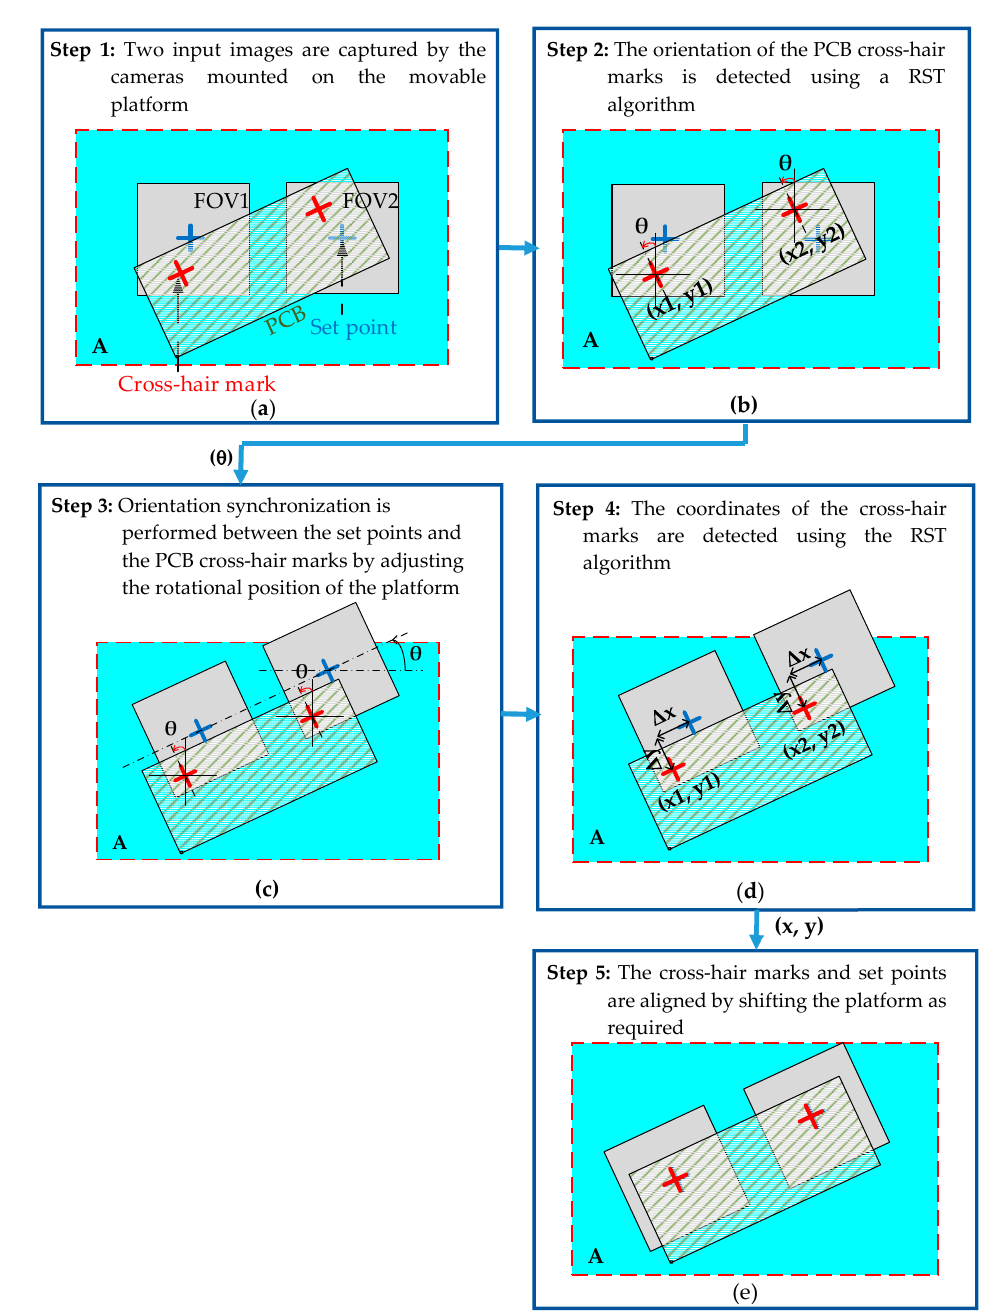
Figure 3. Global framework of the procedure of alignment between the marks on the PCB surface and the set points in the field of views (FOVs) of cameras; (a) initial positions of marks are detected after assigning new PCB. FOV1 and FOV2 : fields of view of cameras 1 and 2, respectively; A: settle area of PCBs. (b) Orientation angle of PCB is detected using the rotation, scale and translation (RST) algorithm; θ : rotation angle of mark. (c) Orientation synchronization is performed between the movable platform and the PCB. (d) Coordinates of marks are detected and the distances between the marks and the set points are computed; ( x1, y1 ) and ( x2, y2 ): coordinates of marks; Δ x and Δ y : distances between marks and set points; (e) Platform is translated in x and y directions to achieve alignment between the marks and the set points.